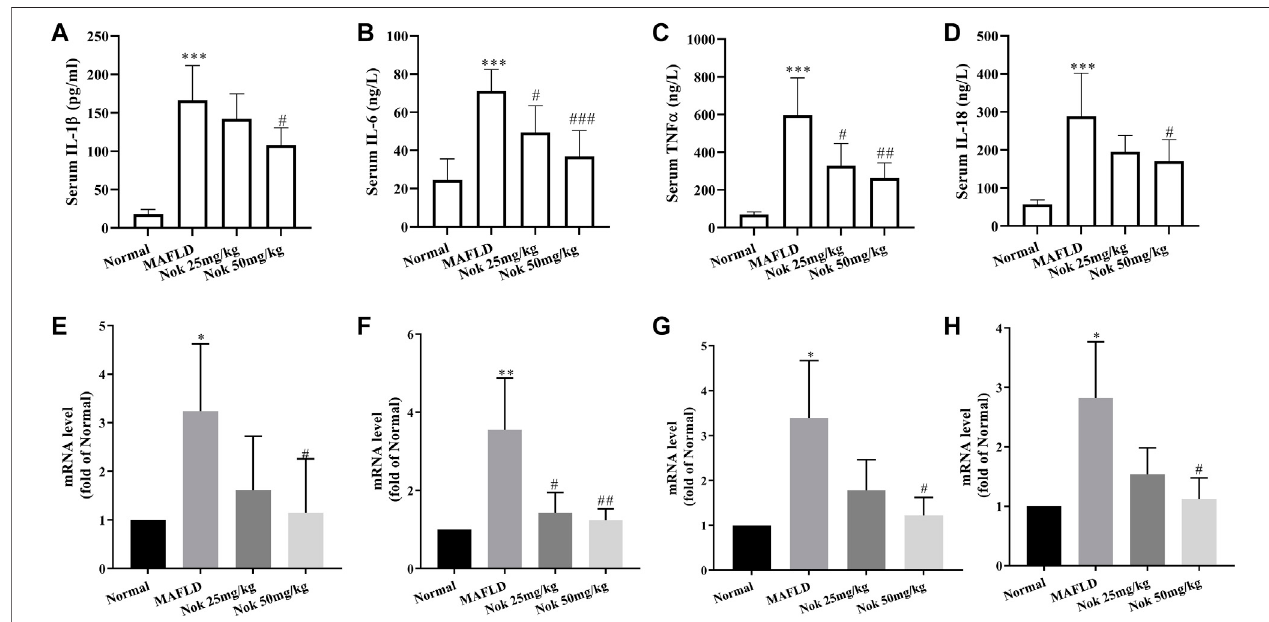
FIGURE 7 | Anti-in fl ammatory effects of Nok. After 12 weeks of daily administration of Nok to C57BL/6J mice fed a HFD, the serum IL-1 β (A) , IL-6 (B) , TNF α (C) , and IL-18 (D) levelsweretested.Atthesametime,wedetected themRNAlevelsofIL-1 β (E) ,IL-6 (F) ,TNF α (G) ,and IL-18 (H) inlivers.Valuesarethemeans±SD(n=6 per group). * p < 0.05, ** p < 0.01, *** p < 0.001 vs. C57BL/6J normal mice. # p < 0.05, ## p < 0.01, ### p < 0.001 vs. the MAFLD model